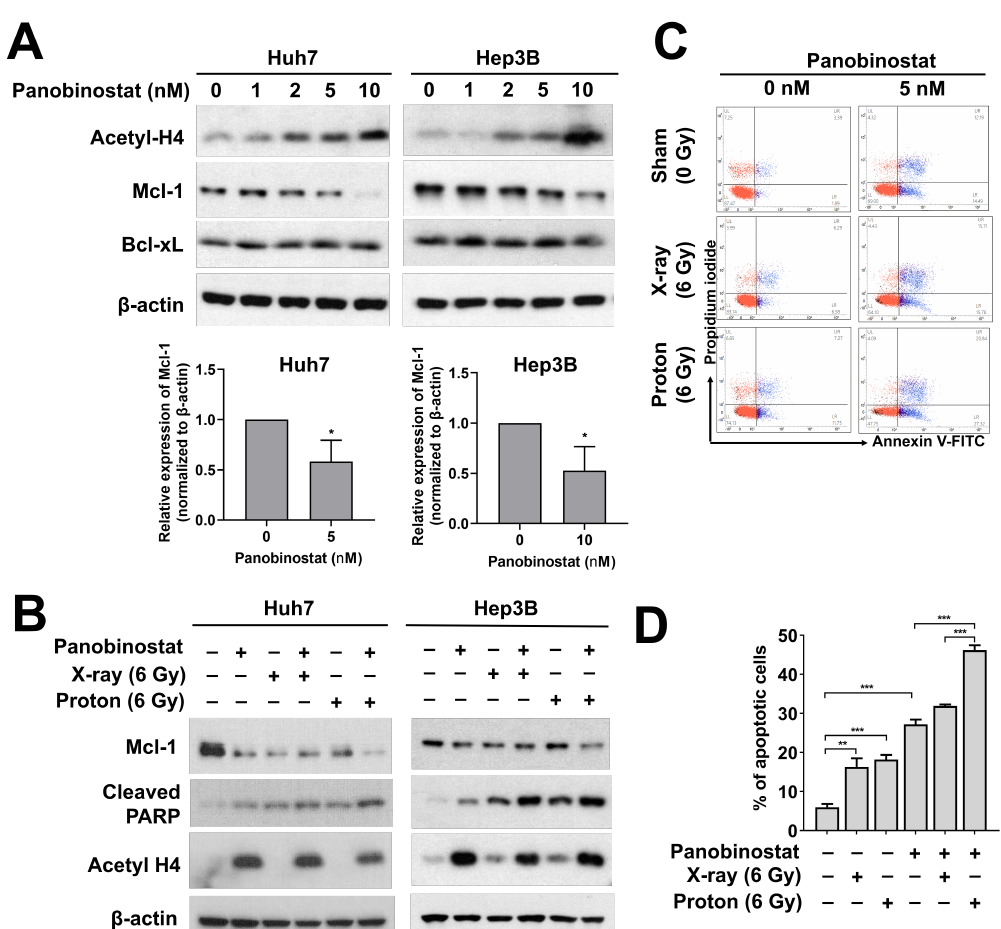
Figure 5. Effects of panobinostat combined with X-rays or protons on apoptotic signaling in HCC cells. ( A ) Huh7 and Hep3B cells were treated with the indicated concentrations of panobinostat and were harvested at 24 h. Western blot analysis showed that panobinostat decreased Mcl-1 but not Bcl-xL in a concentration-dependent manner. Concomitant enrichment of acetylated histones H4 was also seen. β -actin was used as a loading control. Relative expressions of Mcl-1 normalized to β -actin were presented. The data represent the mean ± S.D. (n = 3); * p < 0.05. ( B ) Co-treatment with panobinostat and radiations further induced apoptotic cell death in HCC cells. HCC cells were pre-treated with panobinostat (5 nM for Huh7 and 10 nM for Hep3B) for 3 h, followed by 6 Gy of X-rays or protons. The cells were harvested 72 h post-irradiation. The combination with panobinostat and proton further decreased Mcl-1 expression with an increase in cleaved PARP expression, a surrogate marker for apoptosis. β -actin was used as a loading control. ( C ) Flow cytometry showed enhanced apoptotic cell death in response to co-treatment with panobinostat and proton irradiation in Huh7 cells. Apoptosis was detected by Annexin V/propidium iodide double staining. Representative flow cytometry scatter plots were shown. ( D ) Quantification of apoptotic cell population. The data represent the mean ± S.D. (n = 3); ** p < 0.01; *** p <